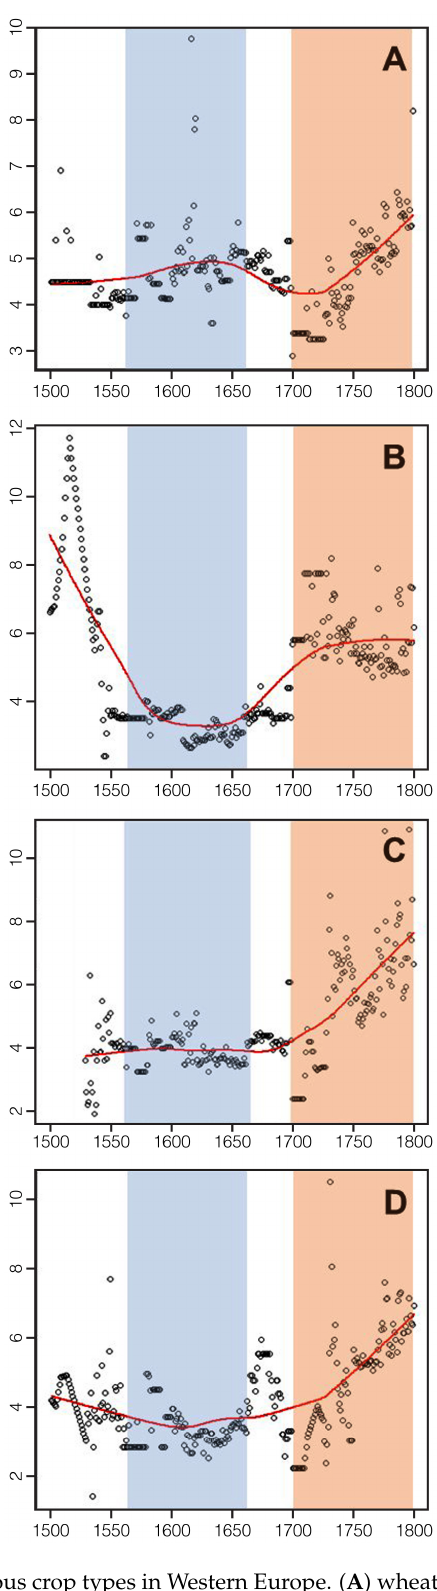
Figure 5. Yield ratio of various crop types in Western Europe. ( A ) wheat; ( B ) rye; ( C ) barley; ( D ) oats. Note: Scatter plots in the figure are the raw data of crop yield ratio. Red line represents the general trend of crop yield ratio that is derived from non-parametric analysis. Blue shade indicates the extreme cooling period during the Little Ice Age (AD 1560–1660), while red shade indicates the warm agricultural recovery period (AD 1700–1800).